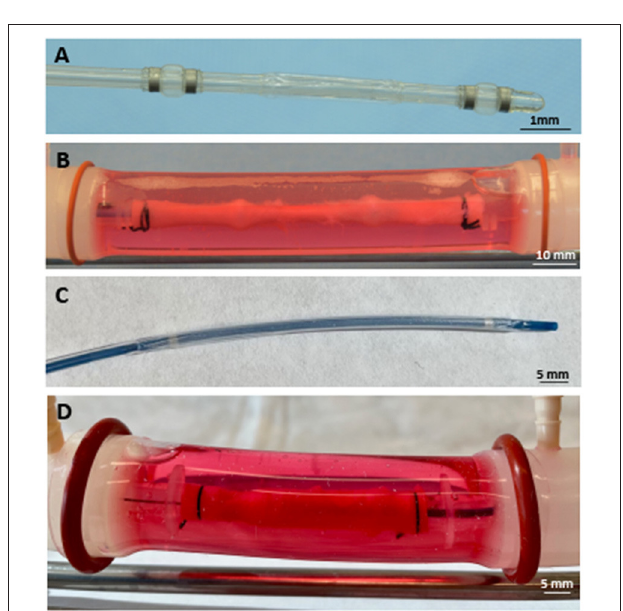
FIGURE 2 | Deployed drug delivery devices. (A) Representative photograph of the perfusion catheter. (B) Image of the perfusion catheter system deployed within the explanted pig artery. Due to the optical clarity of the system, the proximal and distal occlusion balloons are clearly visible and can be identified in the artery. (C) Representative photograph of the drug-coated balloon. (D) Image of the drug-coated balloon deployed within the explanted pig